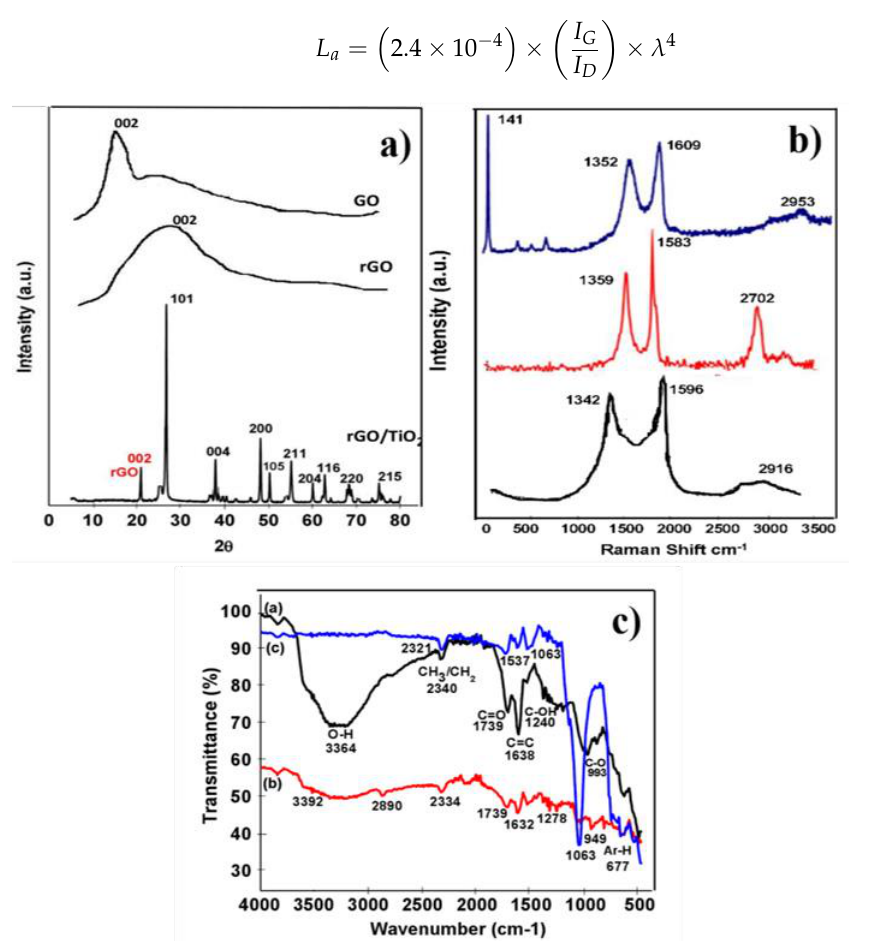
Figure 2. ( a ) X-ray diffraction, ( b ) Raman shift, and ( c ) FTIR analysis spectra of GO, rGO, and rGO/TiO 2 . Table 1. XRD analysis for rGO and TiO 2